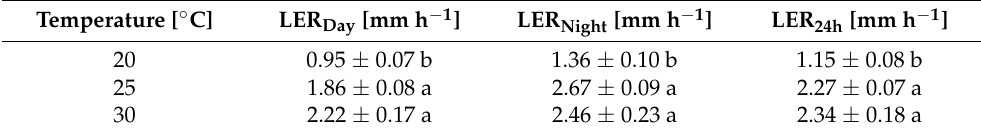
Table 3. Leaf elongation rate (LER) during day, night and 24 h at 3 different constant day/night temperatures and constant RH of 65%. Mean values and standard errors are given. Different letters indicate significant differences at p < 0.05 between temperature